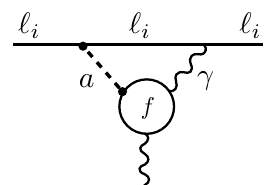
Figure 34 . Two-loop diagram contributing to lepton anomalous magnetic moments, involving only ALP-fermion couplings. The fermion label f runs over all fermion species.